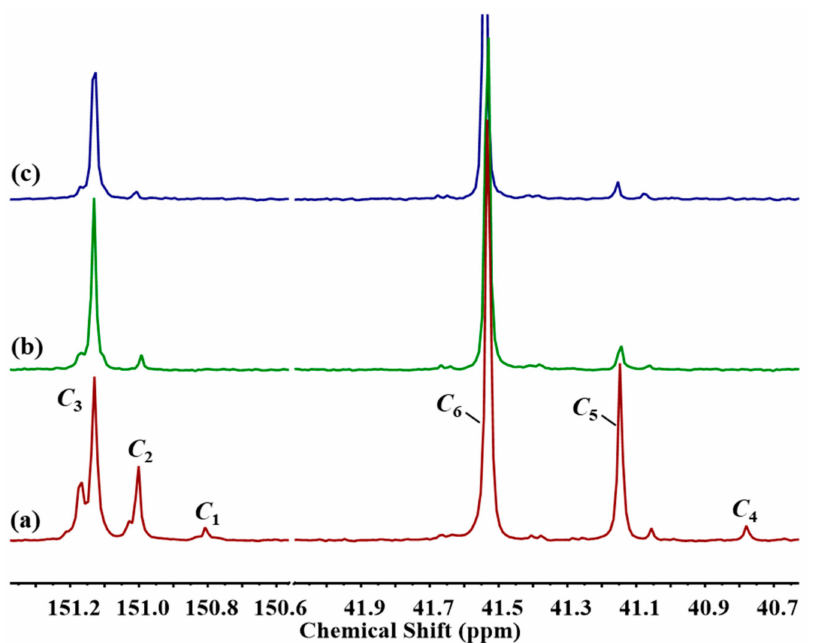
Figure 10. 13 C-NMR spectra of PC-PDMS copolymers using ( a ) Silanol 5.3 , ( b ) Silanol 22.5 , and ( c )